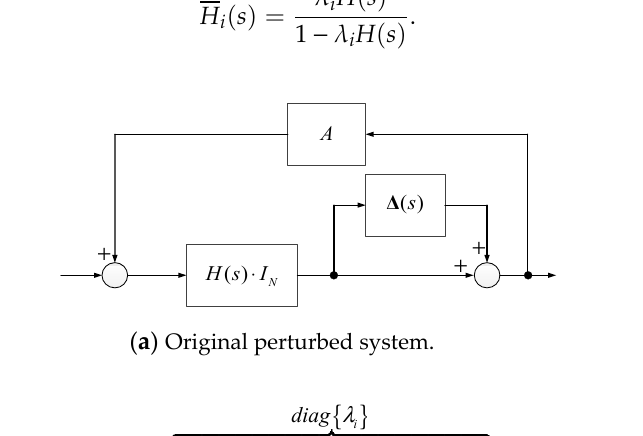
Figure 12. Sector bounded nonlinearities to capture the uncertainty of tire-force characteristics.